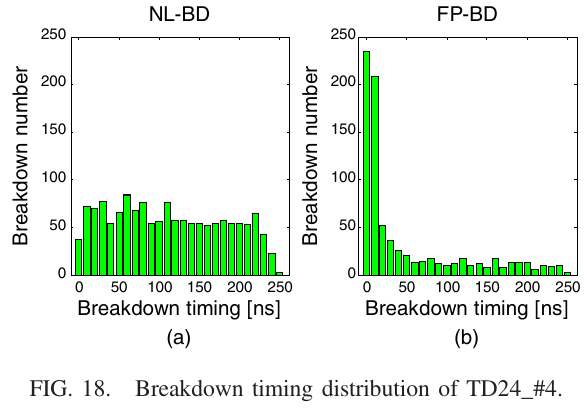
FIG. 18. Breakdown timing distribution of TD24_#4.